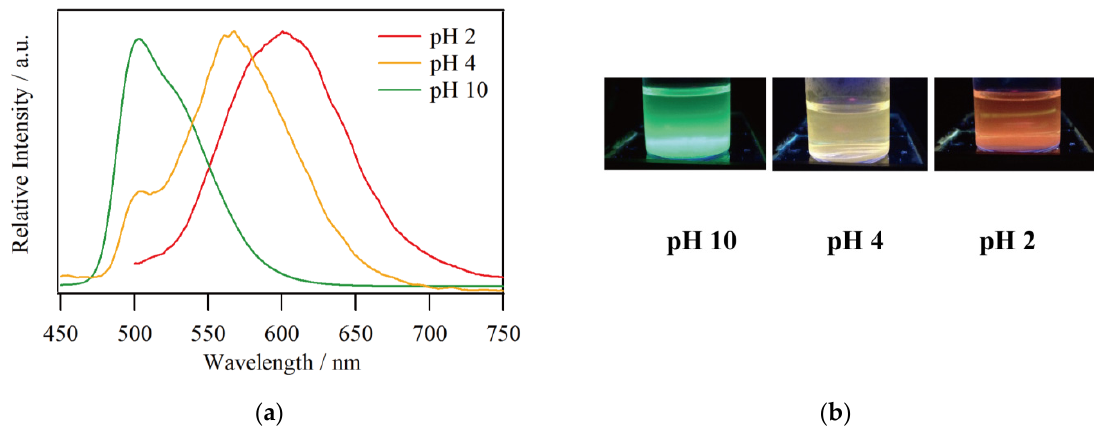
Figure 3. ( a ) Emission spectra and ( b ) photographs of 1 in MeOH/CHCl 3 with buffer at pH 2, 4, and 10 under UV irradiation ( λ ex = 365 nm).